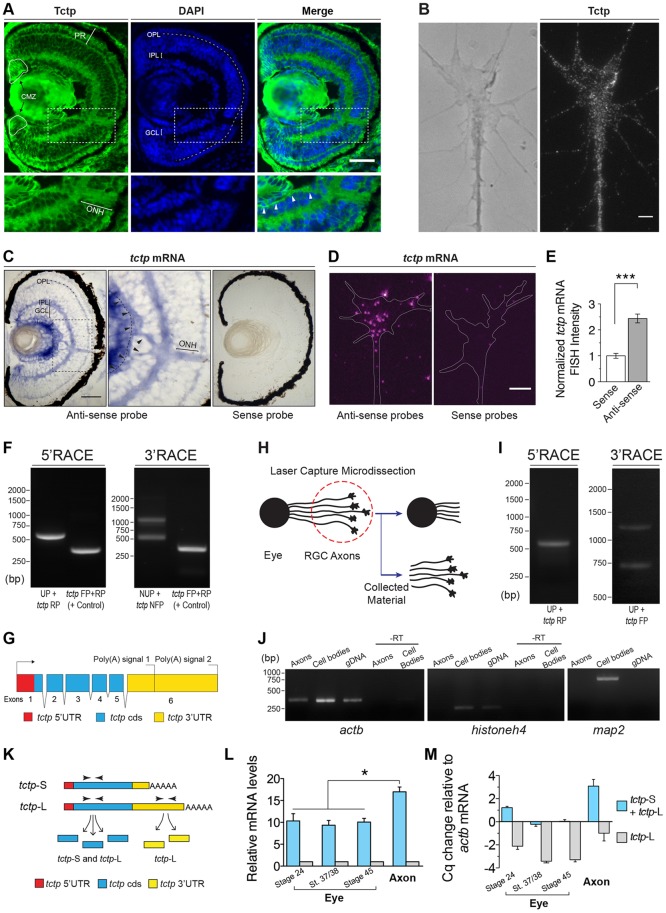
Expression of tctp in the
Xenopus
neural retina. (A) Coronal section of stage 43 retina probed with an anti-Tctp antibody and counterstained with DAPI. Arrowheads indicate the optic fibre layer (OFL). The boxed area is enlarged beneath. The dashed contour delineates the outer plexiform layer. (B) Stage 32 eye explants grown in vitro for 24 h were stained with anti-Tctp antibody (left, phase contrast image; right, Tctp antibody staining). Tctp is detected in the axon shaft, central domain and filopodia. (C) In situ hybridisation (ISH) detection of tctp mRNA expression on coronal sections of stage 43 retinas. Arrowheads indicate the OFL. The boxed area is enlarged in the middle panel. (D,E) Quantitative ISH detection of tctp mRNA expression in the RGC axonal and growth cone compartments was performed using stage 32 eye explants grown in vitro for 24 h. Mean±s.e.m.; ***P<0.0001, one-way ANOVA with Bonferroni correction. (F) RACE amplifications of tctp mRNAs using retinal RNA extracts. FP, forward primer; NUP, nested universal primer; RP, reverse primer; UP, universal primer. (G) Organisation of the tctp gene in X. laevis. cds, coding region; poly(A) signal, polyadenylation signal. (H) Schematic of the laser-capture microdissection procedure used to collect RGC axonal extracts. (I) RACE amplifications of tctp mRNAs using laser-captured axonal extracts. (J) Purity assessment of laser-captured material by RT-PCR. –RT, RNA samples not reverse transcribed. (K) RT-qPCR experimental design. (L,M) Axonal and whole-eye content of tctp mRNAs were analysed by RT-qPCR and normalised to actb expression. In L, data are plotted as ‘tctp-S+tctp-L’ to ‘tctp-L’ expression ratios (*P=0.0175, one-way ANOVA), whereas in M the quantification cycle (Cq) difference relative to actb is shown. Scale bars: 50 μm in A,C; 5 μm in B,D. CMZ, ciliary marginal zone; GCL, ganglion cell layer; IPL/OPL, inner/outer plexiform layer; ONH, optic nerve head; PR, photoreceptor layer.